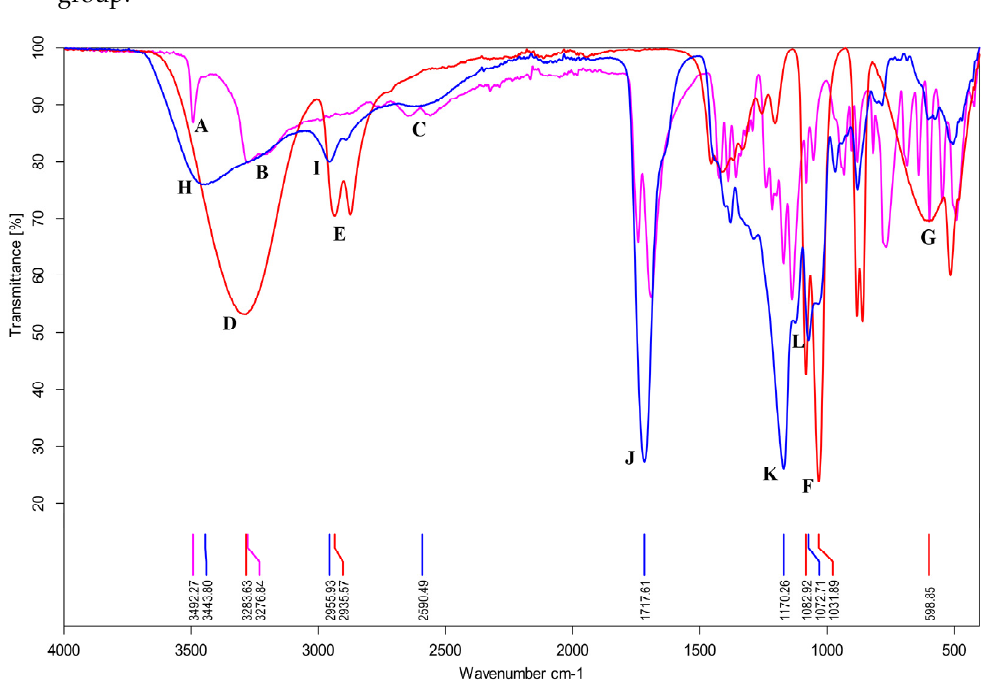
Figure 1. FTIR spectra of 1,2-ethanediol (red), citric acid (pink), and poly(1,2-ethanediol citrate)